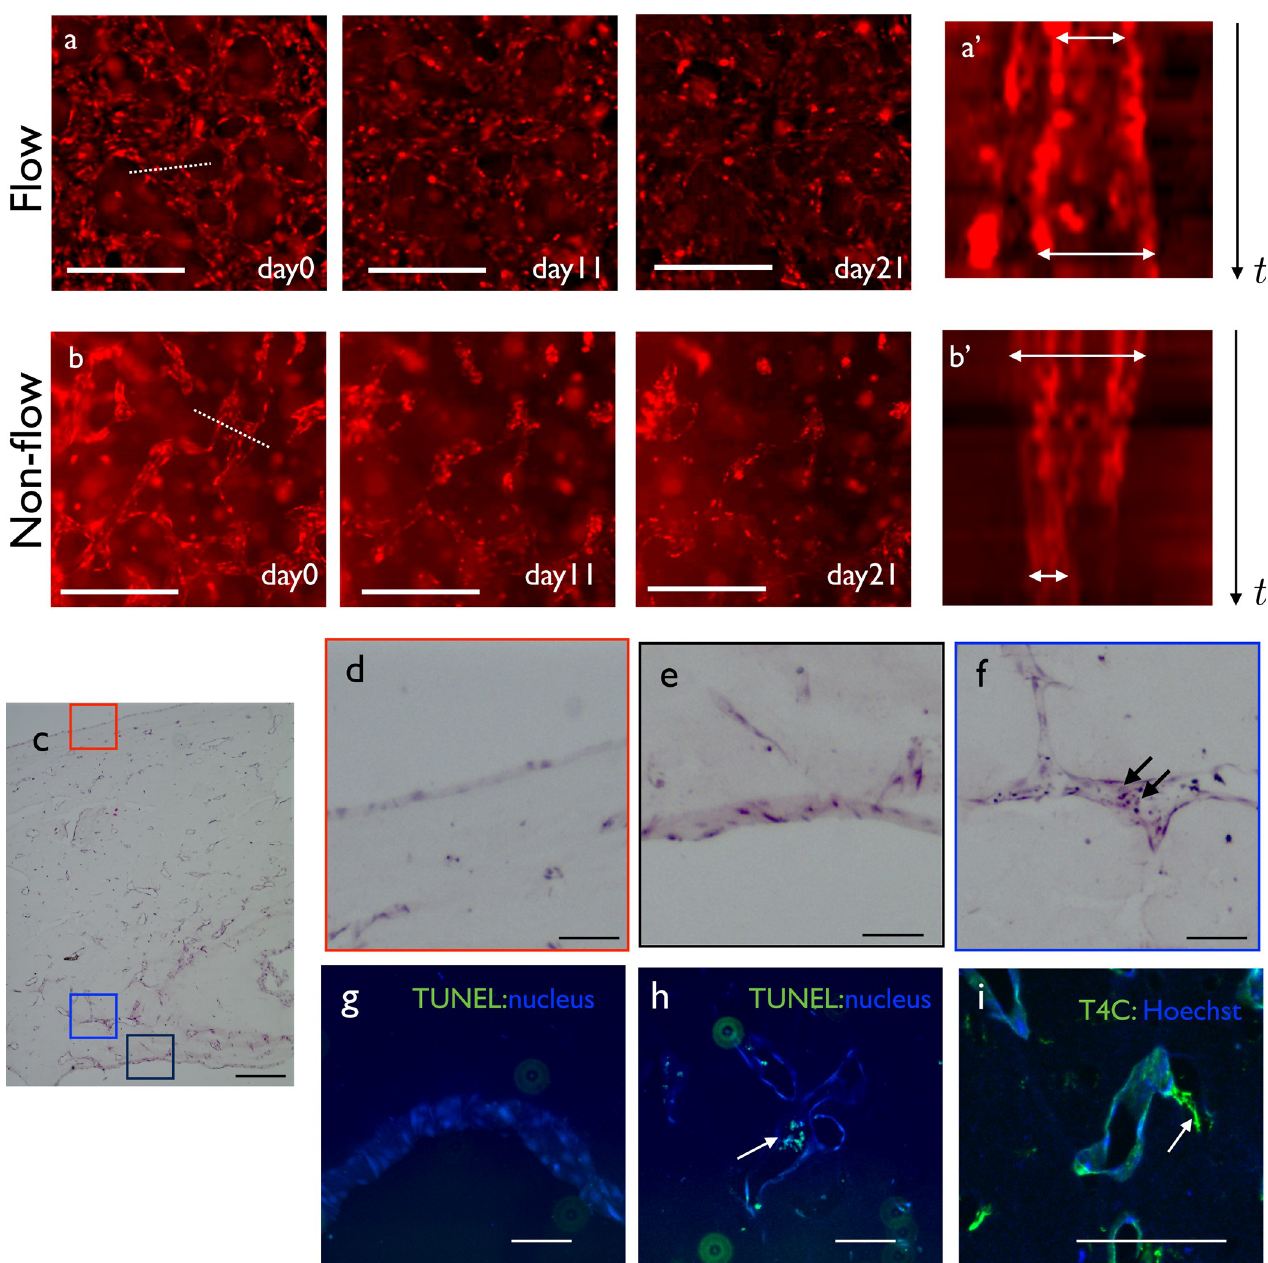
Fig 3. Reconstruction of flow-induced remodeling. (a) Remodeling process at the high flow region from day 0 to 21. (a’) Kymograph of the dotted line region in (a). Vasculature dilated gradually. (b) Remodeling process at the non-flow region from day 0 to 21. (b’) Kymograph of the dotted line region in (b). The vascular diameter decreased. (c) Low magnification view of a hematoxylin-eosin-stained EC monoculture sample. (d) Magnified view of the upper surface of the gel. The surface of the gel was covered by endothelial cells. (e) Magnified view of the large lumen inside the gel. The lumen was also covered by endothelial cells. (f) Magnified view of the small lumen inside the gel. Small necrotic cells were observed inside the lumen (arrows). (g) TUNEL staining of the flow region. No dead cells were observed. (h) TUNEL staining of the non-flow region. Dead cells were observed inside the vasculature. (i) Type IV collagen staining of the long-term culture sample. There were some lumens positive for type IV collagen without cells (arrows), indicating the ECM sheath of the degraded vasculatures in non-flow regions. Scale bars: 500 μ m (a–c); 100 μ m (d–i).